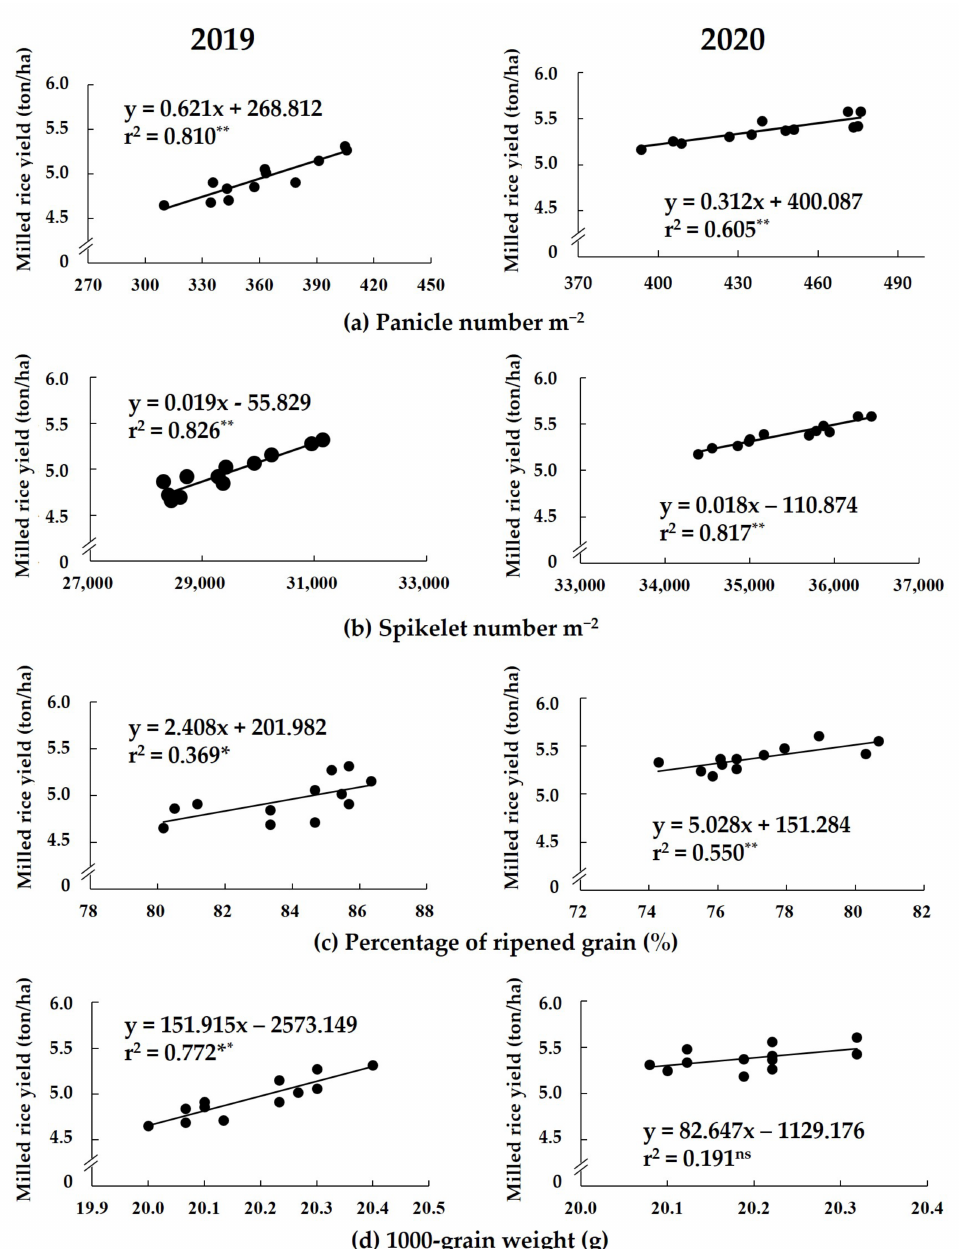
Figure 4. Relationship between the milled rice yield and yield components: ( a ) panicle number m − 2 ; ( b ) spikelet number m − 2 ; ( c ) percentage of ripened grain; ( d ) 1000-grain weight. Each data point is the mean of replicates in 2019 and 2020. The regression analysis was performed using two years of data. * and **: significant at p < 0.05 and 0.01, respectively. ns: not